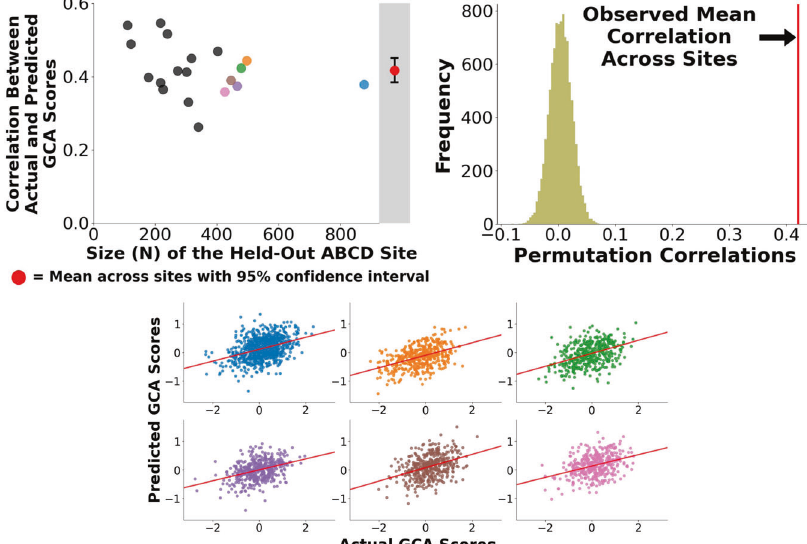
Fig. 2 Correlations between actual GCA scores and GCA scores that are predicted based on brain connectivity. We applied multivariate predictive models to 5937 subjects at 19 sites to identify brain-wide connectivity patterns that are associated with general cognitive ability (GCA). (Upper Left Panel) In leave-one-site-out cross-validation, functional connectivity patterns associated with GCA generalized to 19 out of 19 held-out sites. (Upper Right Panel) The overall mean correlation between observed GCA scores and predicted GCA scores (predicted exclusively from brain connectivity patterns) was 0.42, p PERM < 0.0001 (observed correlation was higher than all 10,000 correlations in the permutation distribution). (Lower Panel) Scatter plots for the six largest held-out sites (blue, orange, green, purple, brown, and pink) show highly consistent performance at individual